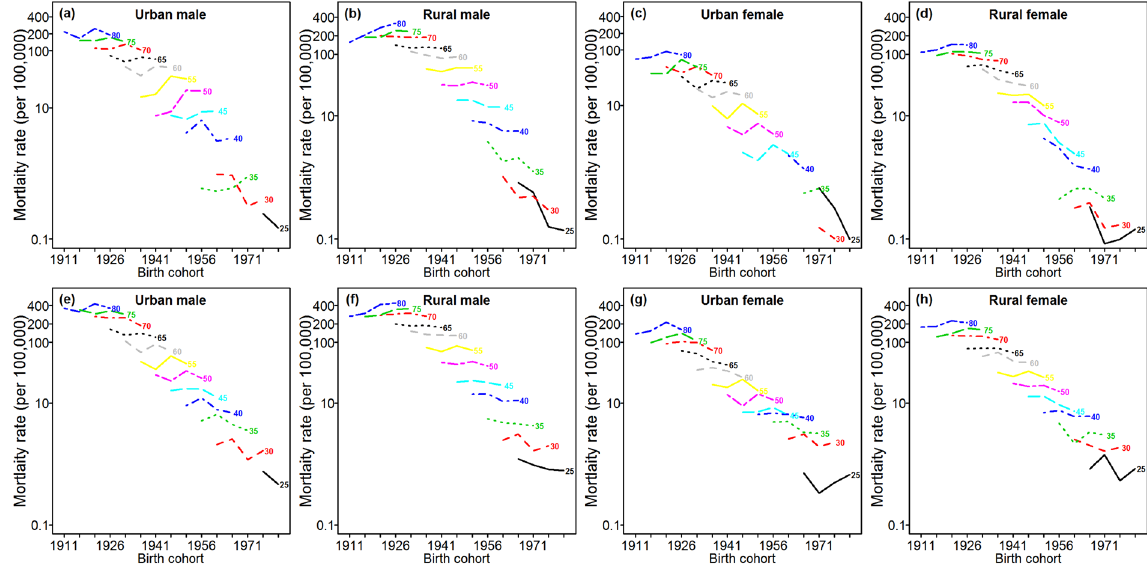
Figure 2. Cohort-specific mortality rates of esophageal and gastric cancers on a log scale in different age groups, stratified by region and sex during the period of 1991–2009. ( a–d ) In the first row represent esophageal cancer mortality; ( e–h ) in the second row represent gastric cancer mortality.